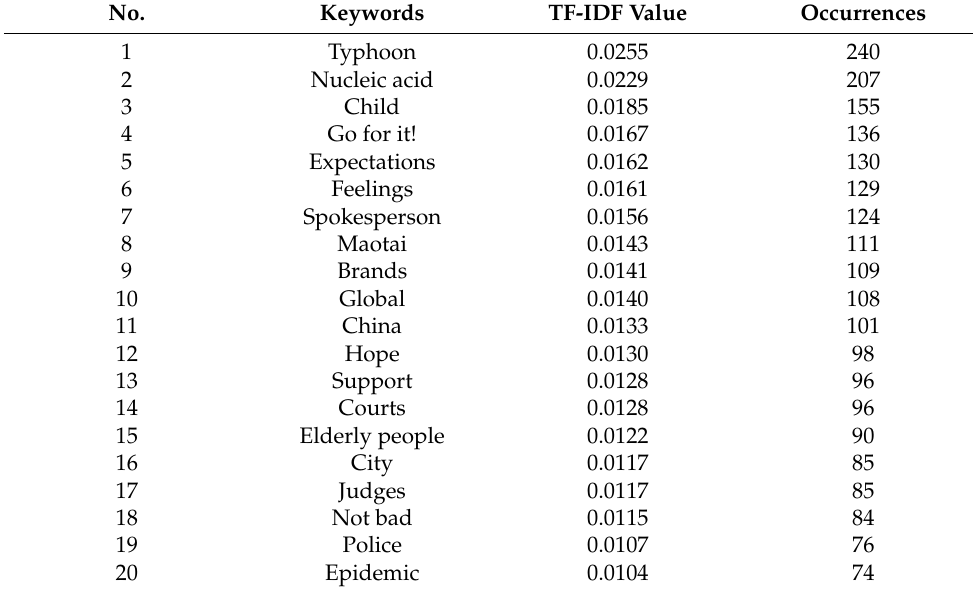
Table 7. Top 20 keywords in C3